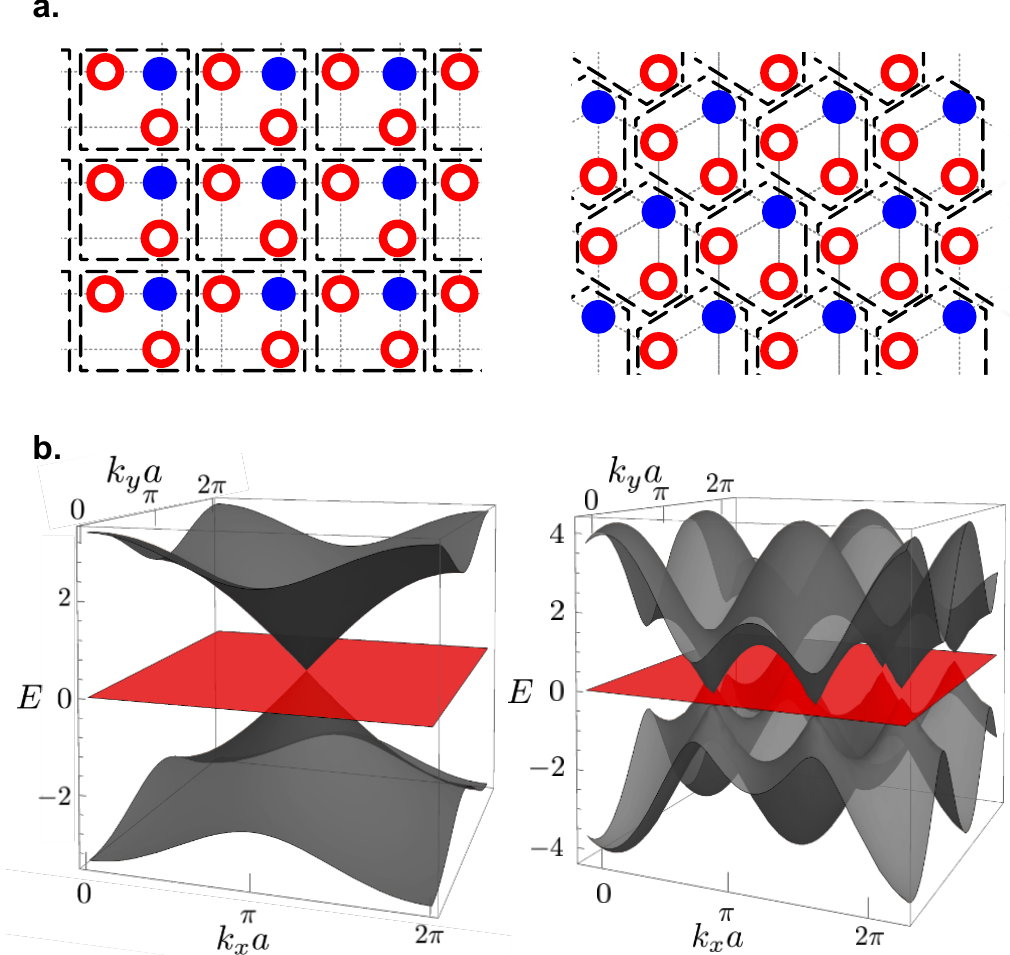
Figure 1: Lattices with a finite chiral charge . a. The Lieb (left) and dice (right) frames are both characterized by an imbalance between the number N A and N B of sites. In both cases the chiral charge per unit cell equals 1. Any Hamiltonian defined on these frames possesses a flat energy band. b. Illustration of two band spectra asso- ciated to chiral Hamiltonians defined on the Lieb (left) and dice (right) frames. The two band spectra are computed for tight-binding Hamiltonians with nearest neigh- bour coupling and a hopping parameter set to 1, see e.g. [ 32 ]